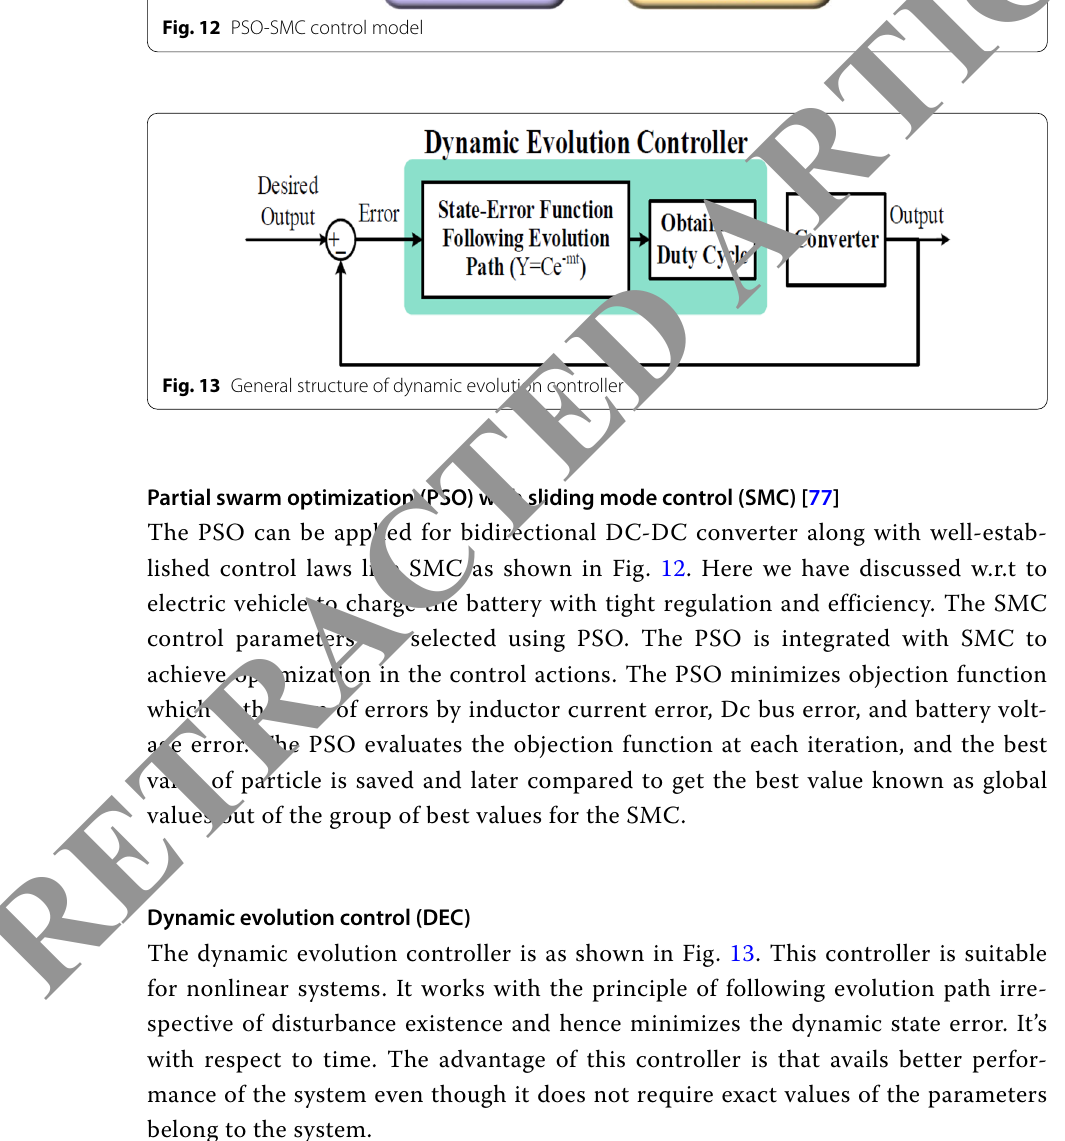
Fig. 12 PSO-SMC control model